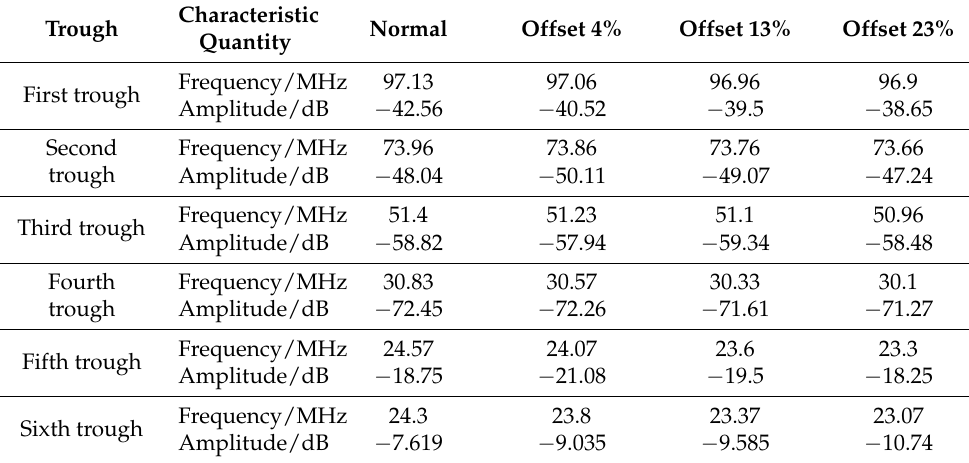
Table 6. Influence of different axis deviation degree of winding on frequency and amplitude of wave trough.